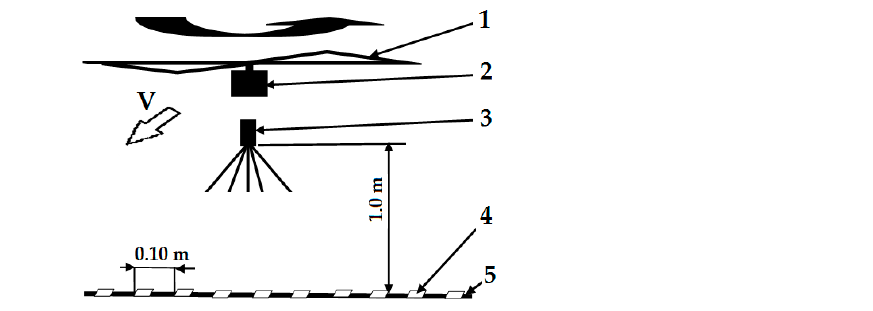
Figure 3. Test stand scheme for the measurement of the transverse distribution of the droplet stream: